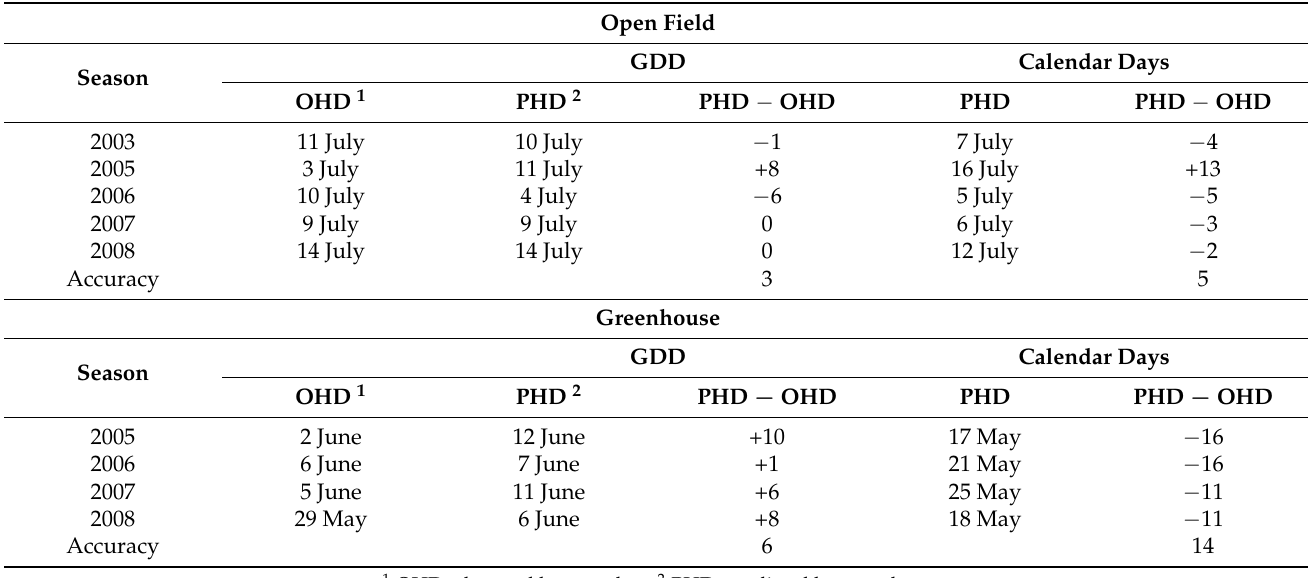
Table 3. Observed and predicted harvest dates for “Flame Seedless” in open field and greenhouse based on GDD and calendar day